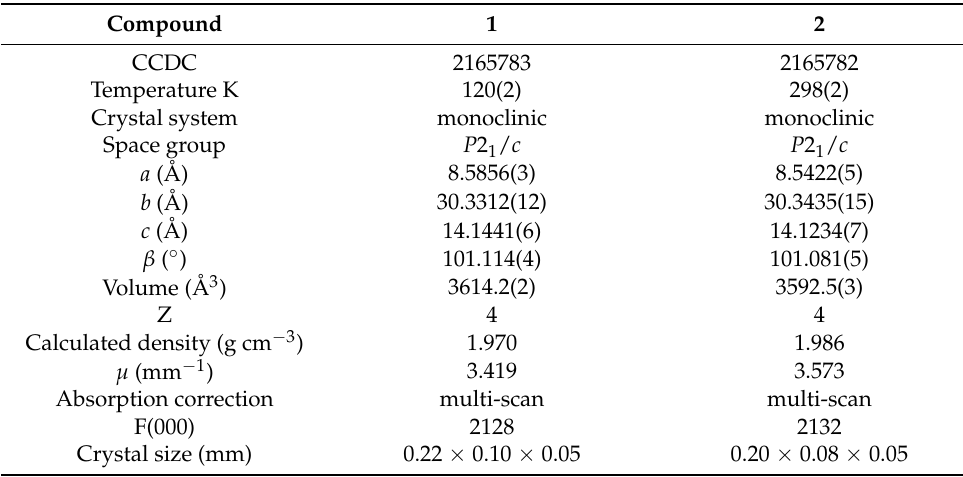
Table 1. Details of data collection and structure refinement parameters for